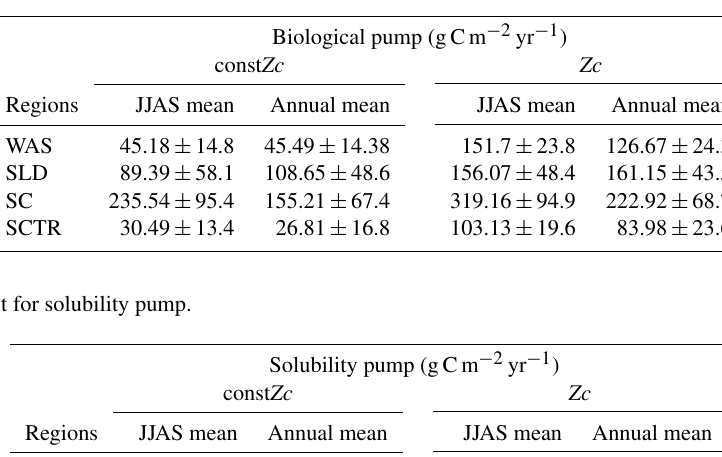
Table 5. Biological pump impact over DIC in the model due to const Zc and var Zc simulations for JJAS and annual mean.